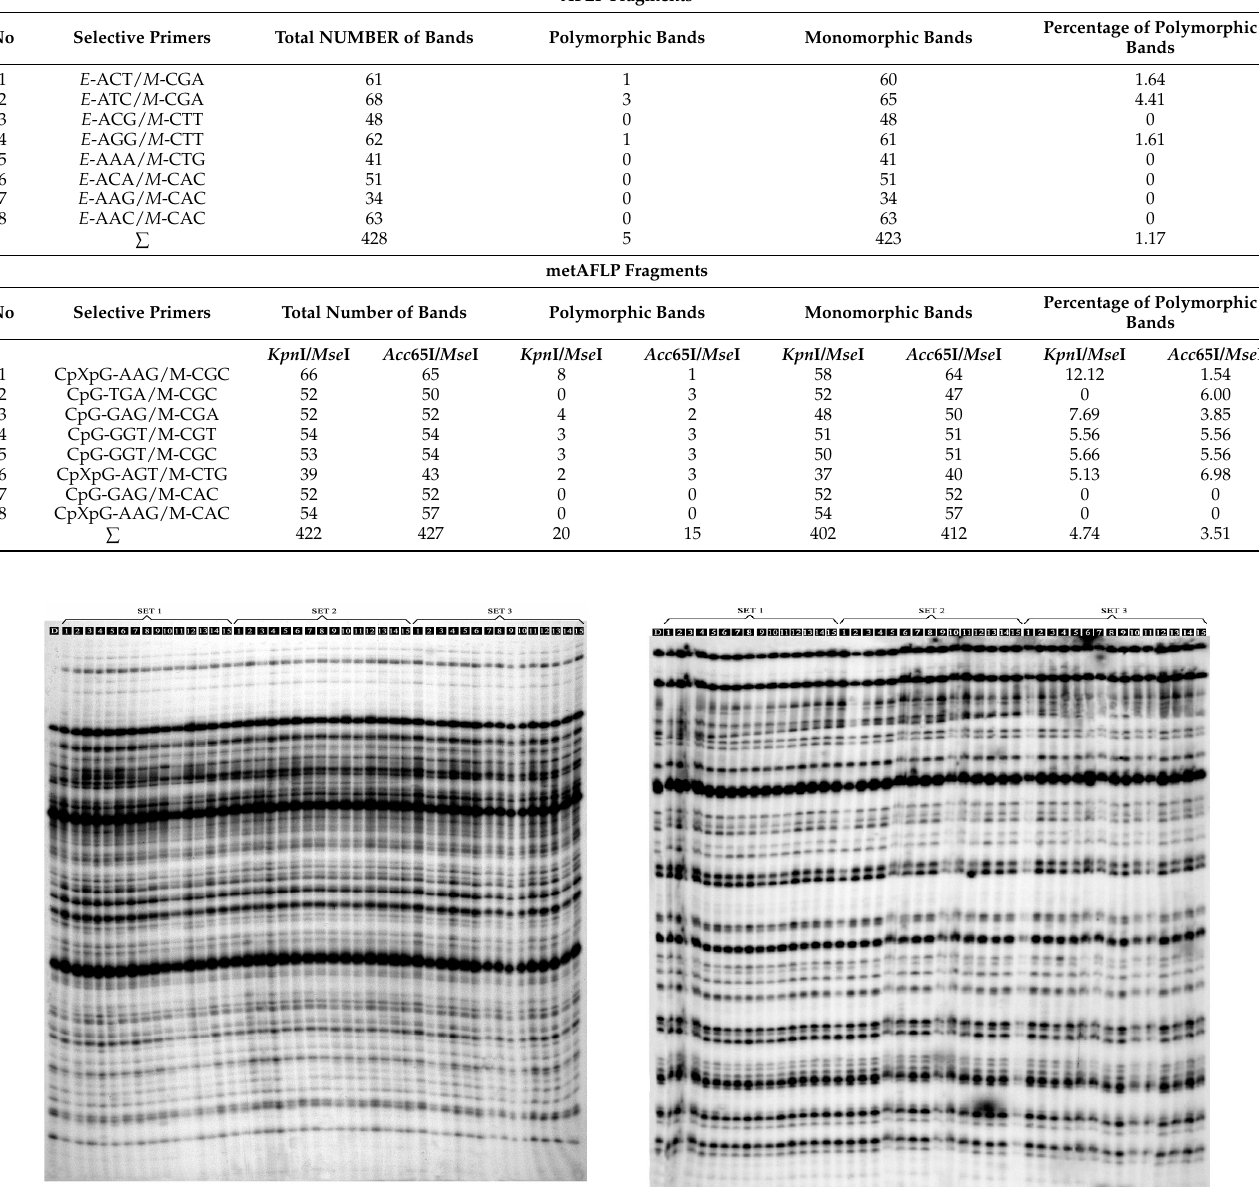
Table 2 . Distribution of AFLP and metAFLP fragments in three groups of regenerants and donor Polyscias filicifolia plant. AFLP Fragments Total NUMBER of No Selective Primers Polymorphic Bands Monomorphic Bands Percentage of Polymorphic Bands Bands